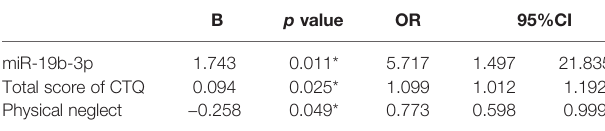
TABLE 2 | The logistic regression of miR-19b-3p and childhood trauma characteristics between the patients with UD and BD. B p value